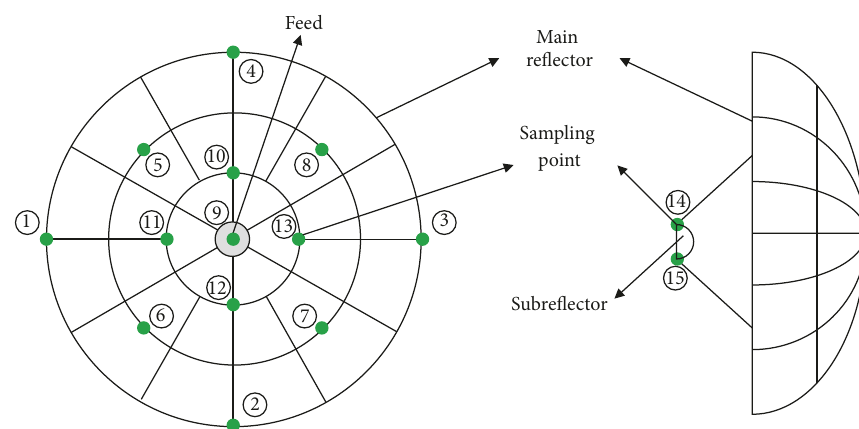
Figure 11: The distribution of sampling points on the